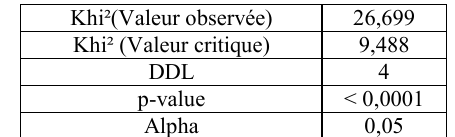
Table 2. Test d'indépendance entre les lignes et les colonnes